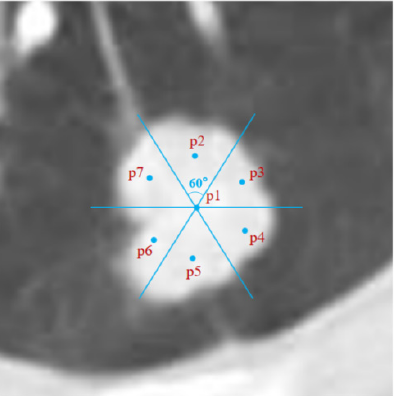
Figure 2. P1 is the initial seed point automatically selected on the target tumor; p1 expands p2, p3, p4, p5, p6, and p7 in a set way and serves as six initial seed points of expansion in the input image.